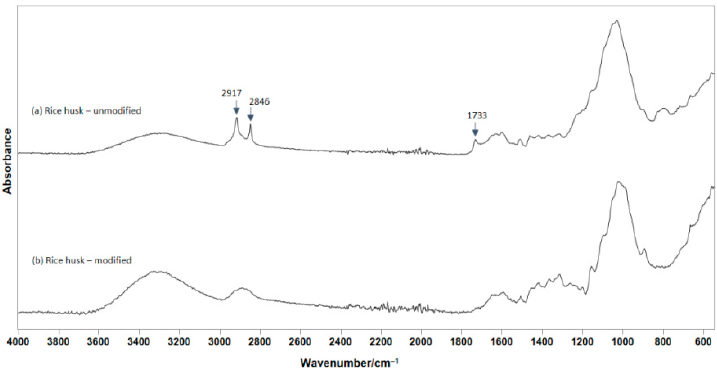
Figure 8. Attenuated total reflectance-infrared (ATR-IR) spectra of raw unmodified ( a ) and S20_70/30 modified ( b ) rice husk.